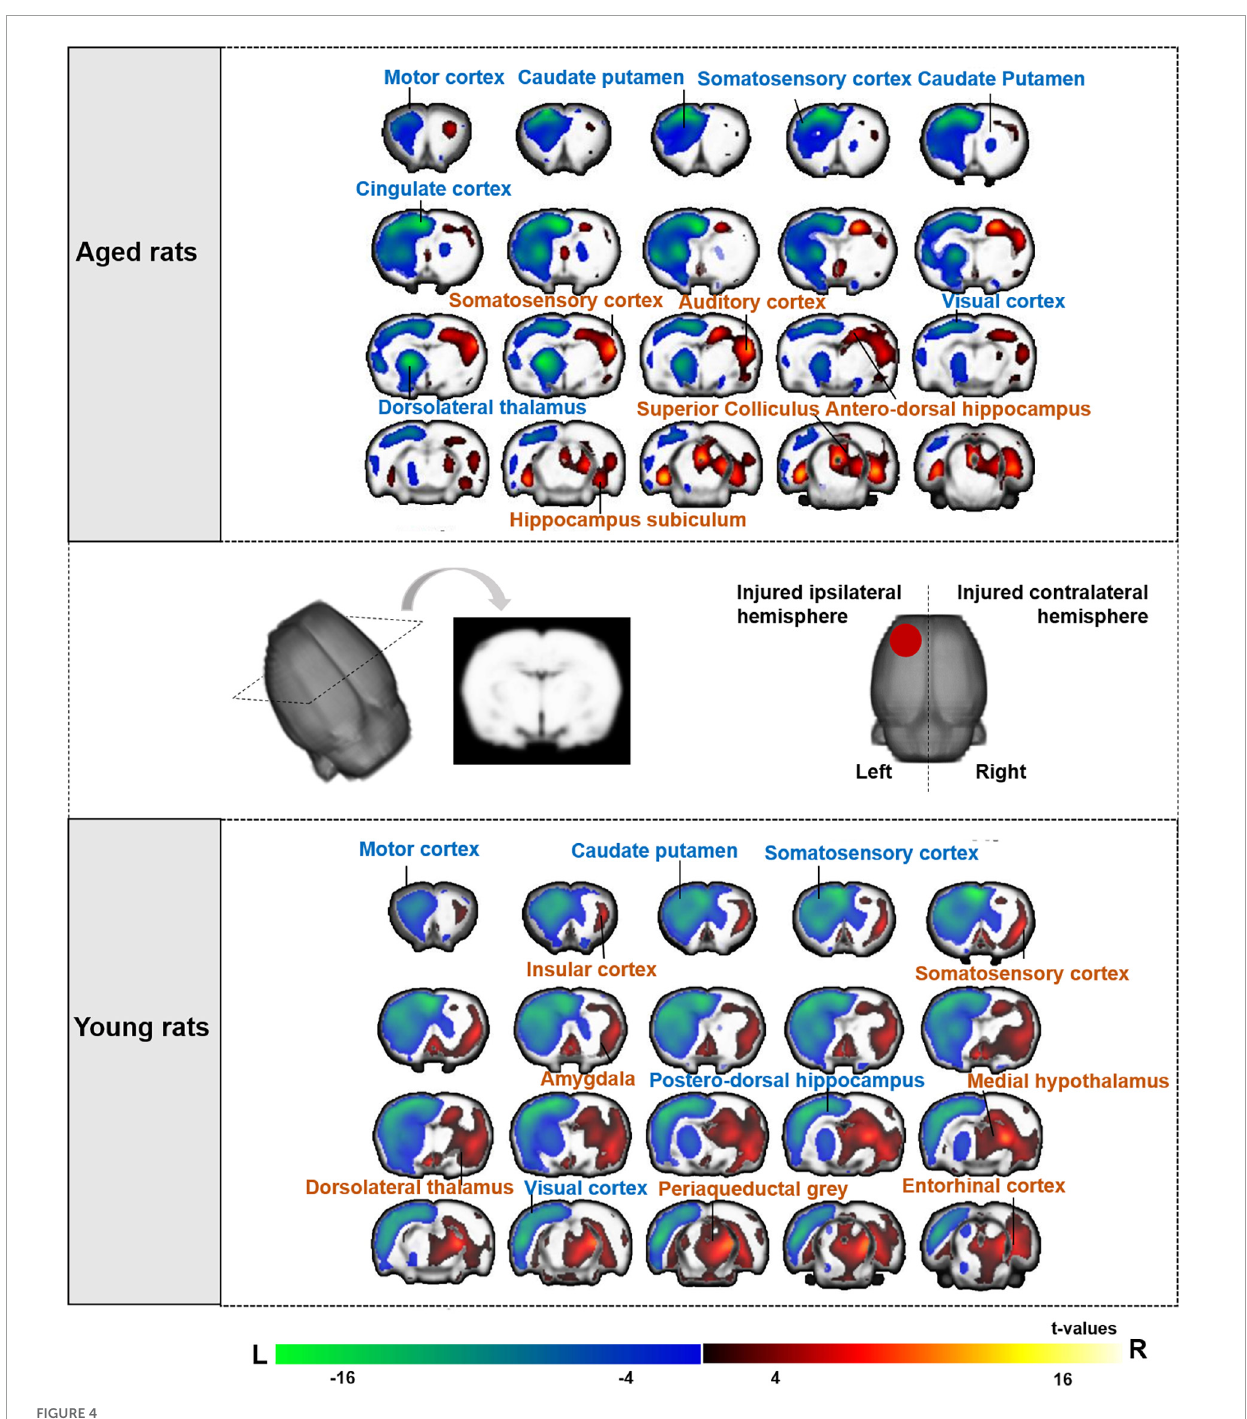
FIGURE4 Brain regions of aged and young rat showing significant differences in metabolic activities after TBI compared with baseline. The changes of aged rats’ cerebral glucose metabolism after TBI were presented in the top of figure, and the changes of young rats were presented in the bottom of figure. Both aged and young rats showed extensively decreased metabolism on left (the injured ipsilateral) hemisphere after TBI. The warm color on brain region showed significant higher metabolic activities after TBI compared with baseline, while cold color showed significant lower metabolic activities after TBI compared with baseline. ( ) Red circle on rat brain showed the injured (left) hemisphere. TBI, traumatic brain injury; L, left, R,